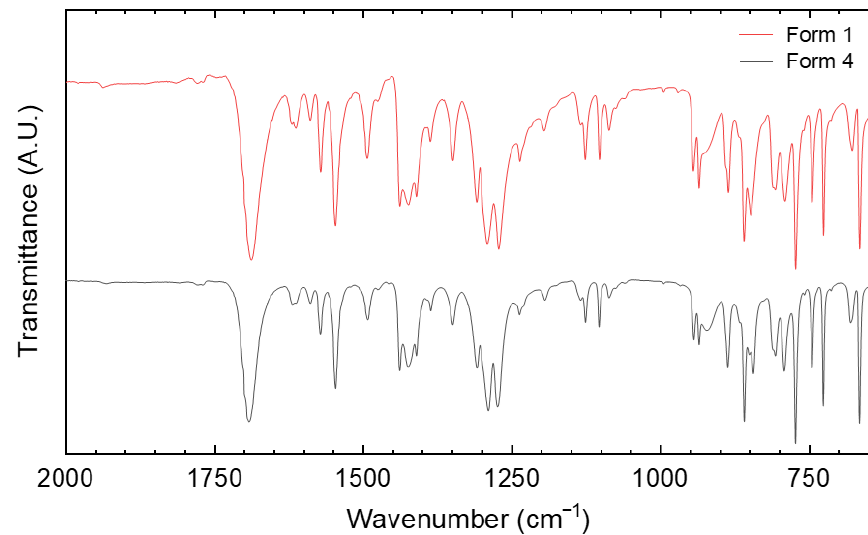
Figure 7. Plot of the ATR-FTIR transmittance spectra, in the most relevant portion (2000–650 cm − 1 range), clearly showing the substantial identity of the FTIR traces of Tafamidis Form 1 and Form 4, preventing polymorph recognition by conventional vibrational spectroscopy (see text).